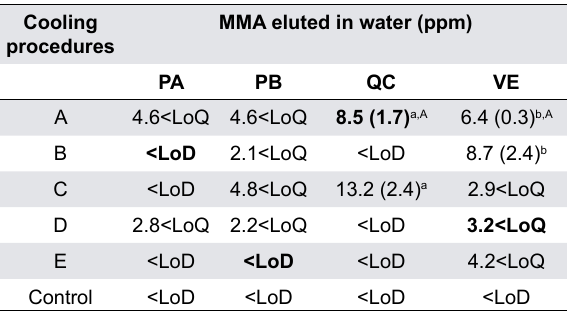
Table 1- The results of the MMA concentration in the water- eluents of the heat-cured PMMA denture base materials